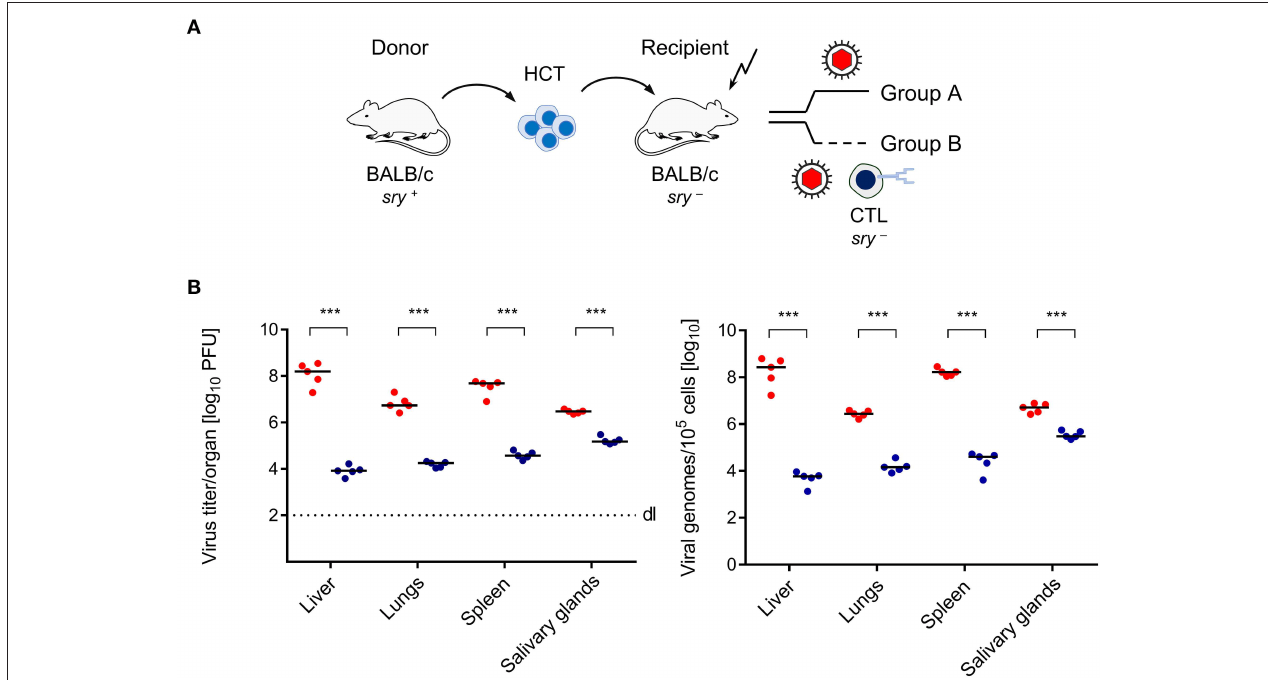
FIGURE 1 | Control of CMV organ infection by immunotherapy with CD8 + T cells. (A) Sketch of the transplantation model defining group A (no therapy) and group B (therapy with virus-specific CTL). The flash symbol indicates hematoablative conditioning of the HCT recipients by total-body γ -irradiation. (B) Day-14 infection load in the organs of HCT recipients expressed as titers (plaque-forming units, PFU) of infectious virus (left panel) and as numbers of viral genomes (right panel). Symbols (red: group A; blue: group B) represent mice analyzed individually. Median values are marked. Differences between two experimental groups were determined by Student’s t -test based on log-transformed, log-normally distributed data. Significance level: P -values of < 0.001